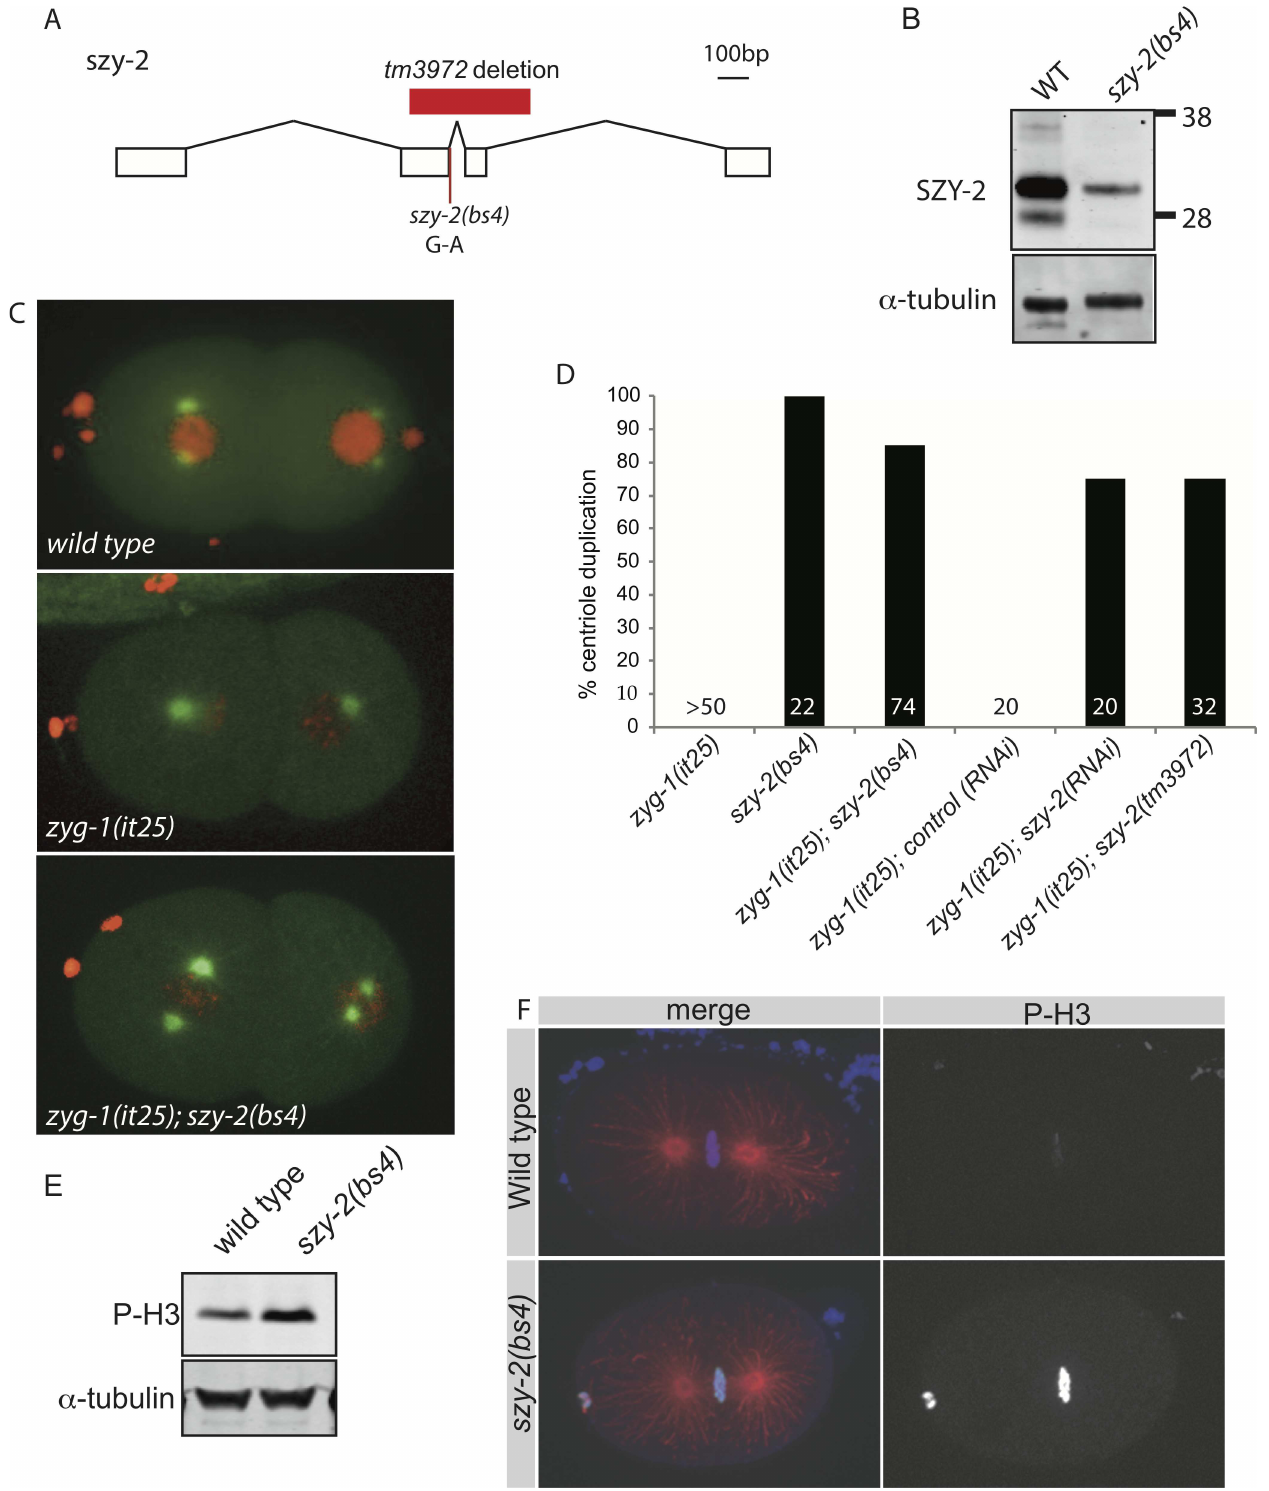
Fig 1. Loss-of-function mutations in the PP1 regulator I-2 SZY-2 rescuesthe zyg-1(it25) phenotype. A) Scale diagramof the structure of the szy-2 gene, indicating the locationof the tm3972 deletionand the szy-2(bs4) splice site mutation. B) Western blot of embryo extracts from wild- type and szy-2(bs4) mutants showeda reducedlevel of the SZY-2 protein. C) Stills from movies of embryos expressingmCherry::H2B and